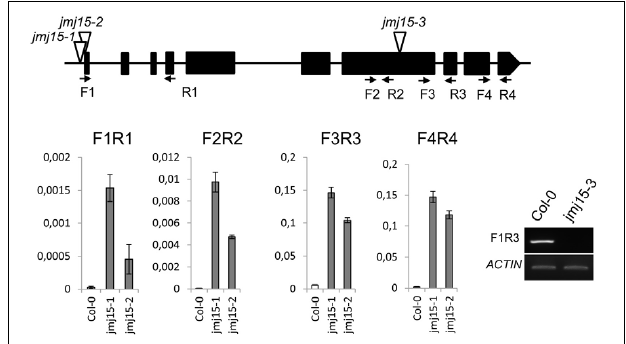
FIGURE 2 | Characterization of JMJ15 T-DNA insertion mutants. The insertion positions of the 3 alleles are indicated by open arrows. The exons are represented by black boxes. The positions of forward (F) and reverse (R) primers are indicated by arrows. The expression levels (relative to ACTIN2 mRNA) in jmj15-1 and jmj15-2 compared to wild type were tested by qRT-PCR using the 4 indicated primer sets. The transcript in jmj15-3 compared to wild type was analyzed by RT-PCR using the indicated primers.